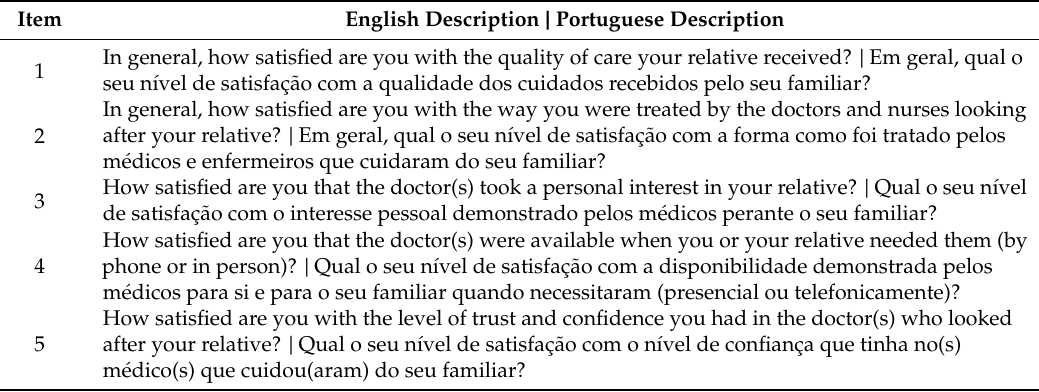
Table 2. Item description of the CANHELP Lite Bereavement